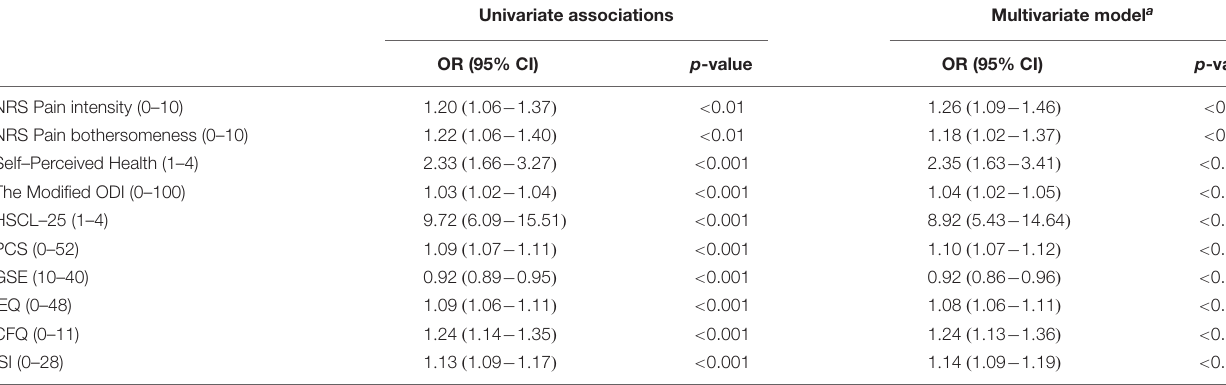
TABLE 4 | Univariate and multivariate associations (odds ratios) between screening positive for PTSD and adverse outcomes. Univariate